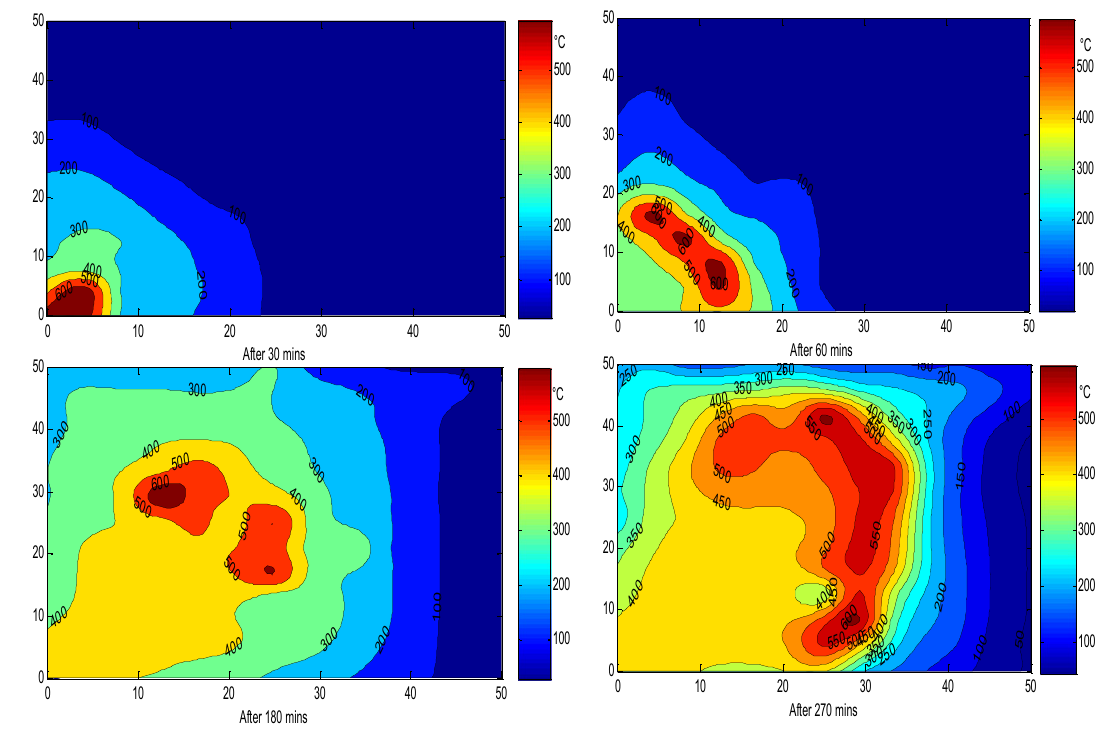
Fig. 4 The combustion front propagation in the model